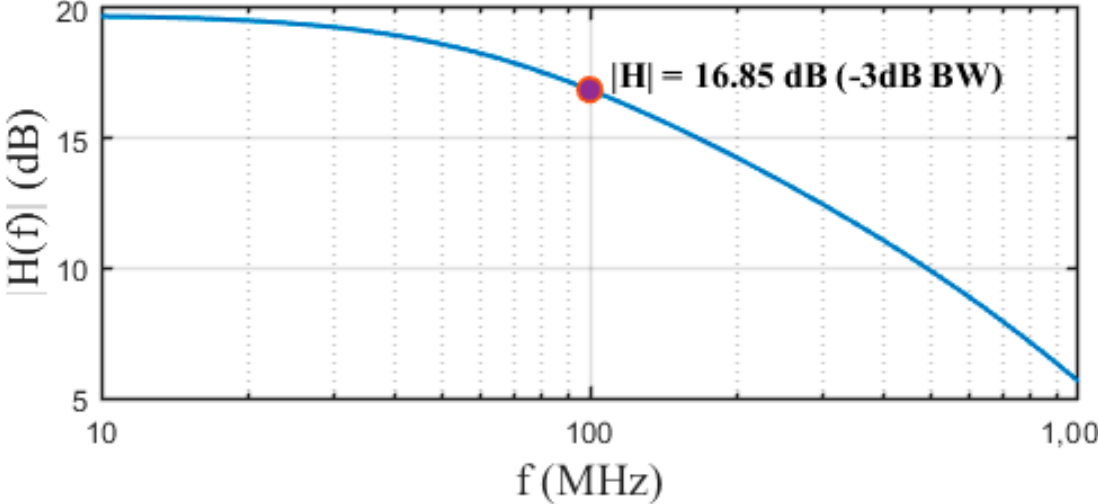
12 of 18 Figure 12. Low-pass filter transfer function: Magnitude (blue) and phase (inset). The intermediate-frequency amplifier is designed using the two-stage differential pair-type architecture of Figure 13a, where pseudo-resistors were used to bias the input transistors of both stages. In Figure 13b its layout is given. ( a )